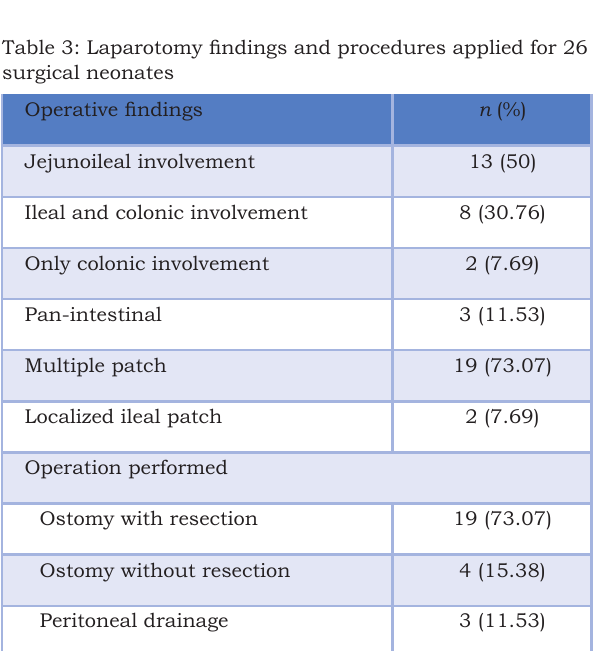
Table 3: Laparotomy findings and procedures applied for 26 surgical neonates Operative